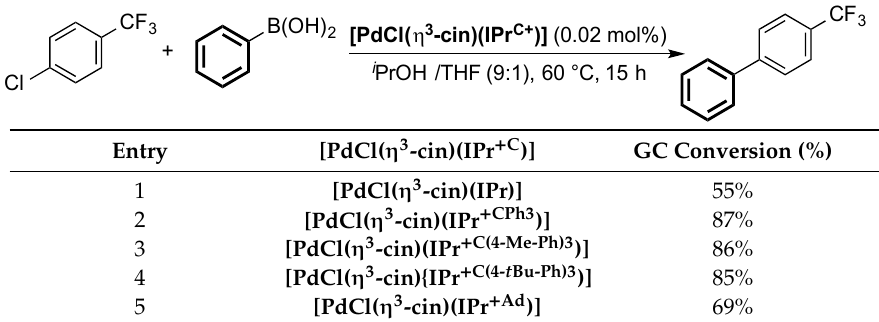
Table 1. Investigation of the [PdCl(η 3 -cin)(IPr +C )] series in Suzuki–Miyaura coupling [65].